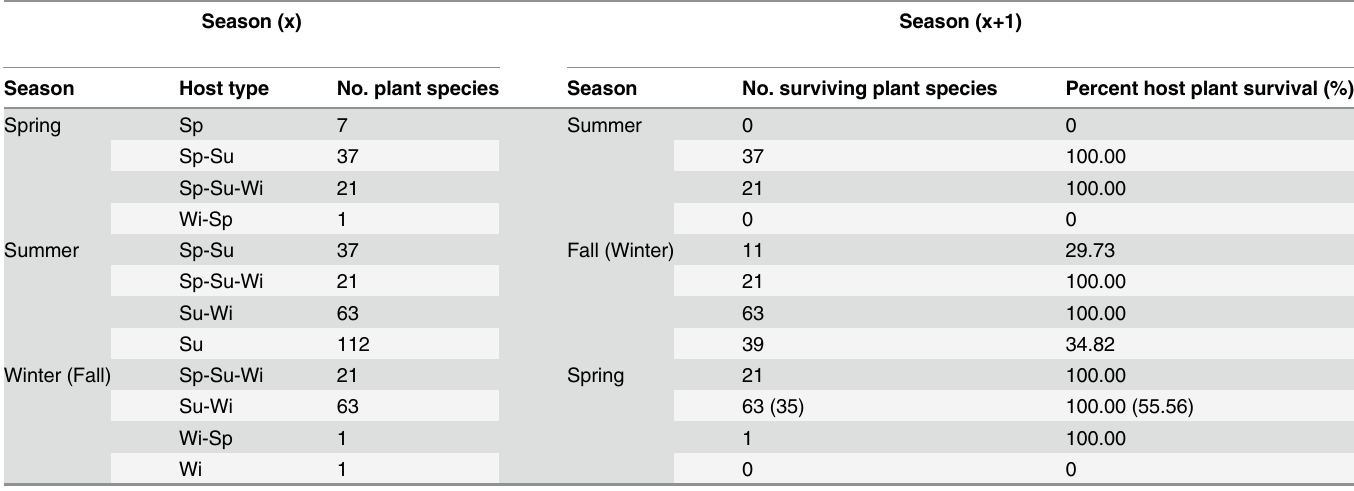
Table 3. Survival of Apolygus lucorum host plants over subsequent seasons at the Langfang experiment station and surroundings (Hebei Province, Northern China). Season (x) Season